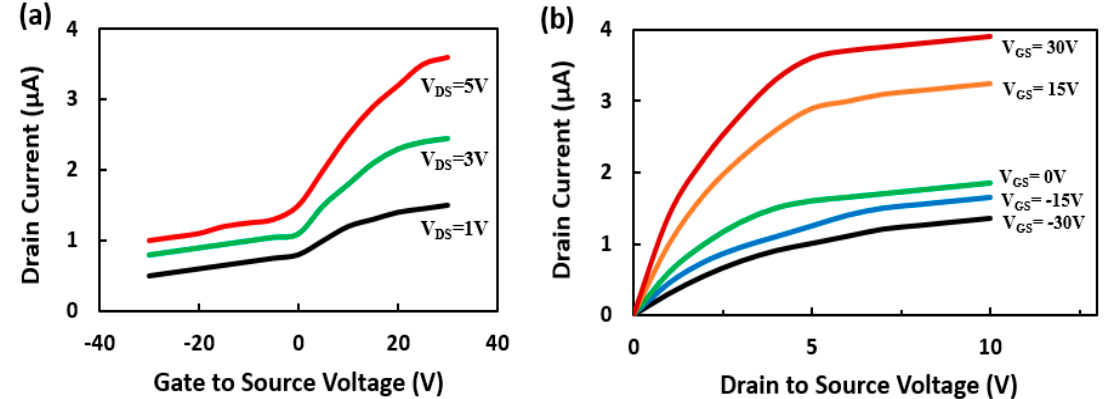
Figure 2. ( a ) I DS vs. V GS plot for the GaN nanowire-based FET device for a V DS of 1, 3, and 5 V. ( b ) I DS vs. V DS plot for the GaN nanowire-based FET device with V GS varied from − 30 V to 30 V at a step of 15 V. All the measurements were done under UV light at room temperature (20 °C).